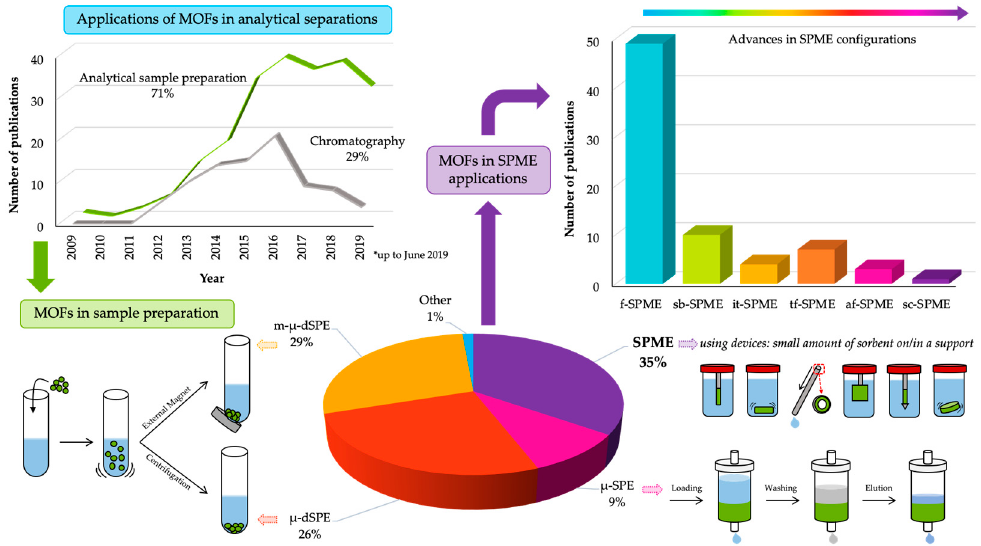
Figure 2. Summary of the number of publications reported up to date involving the use of MOFs in analytical separations, particularly in analytical sample preparation methods. For the definition of the abbreviations, refer to the list of abbreviations at the end of the article.